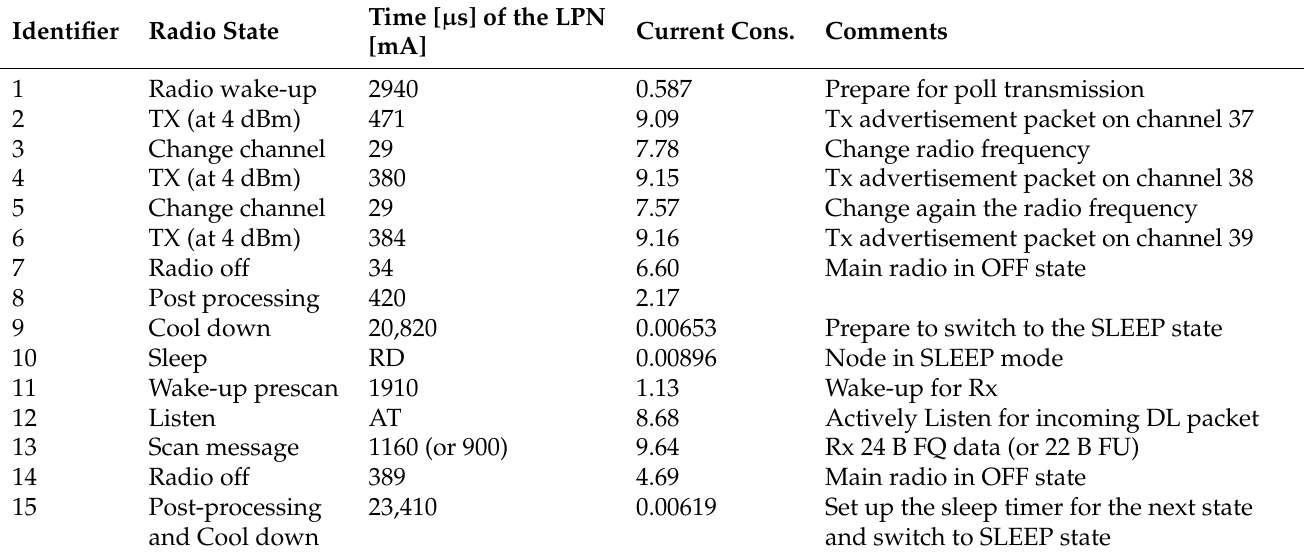
Table 1. State sequence for a poll request and response of a